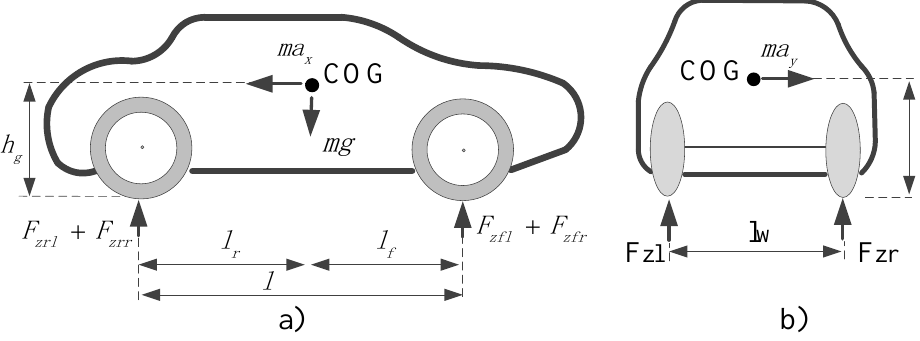
Figure 3. ( a ) Wheel load transfer at positive longitudinal acceleration and ( b ) front axle wheel load variation due to lateral acceleration during left turn.